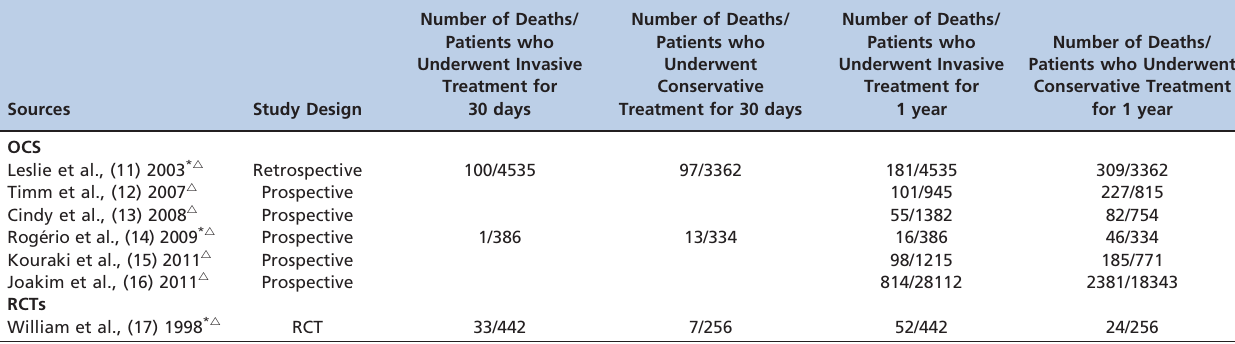
Table 1 - Characteristics of the included NSTE-ACS